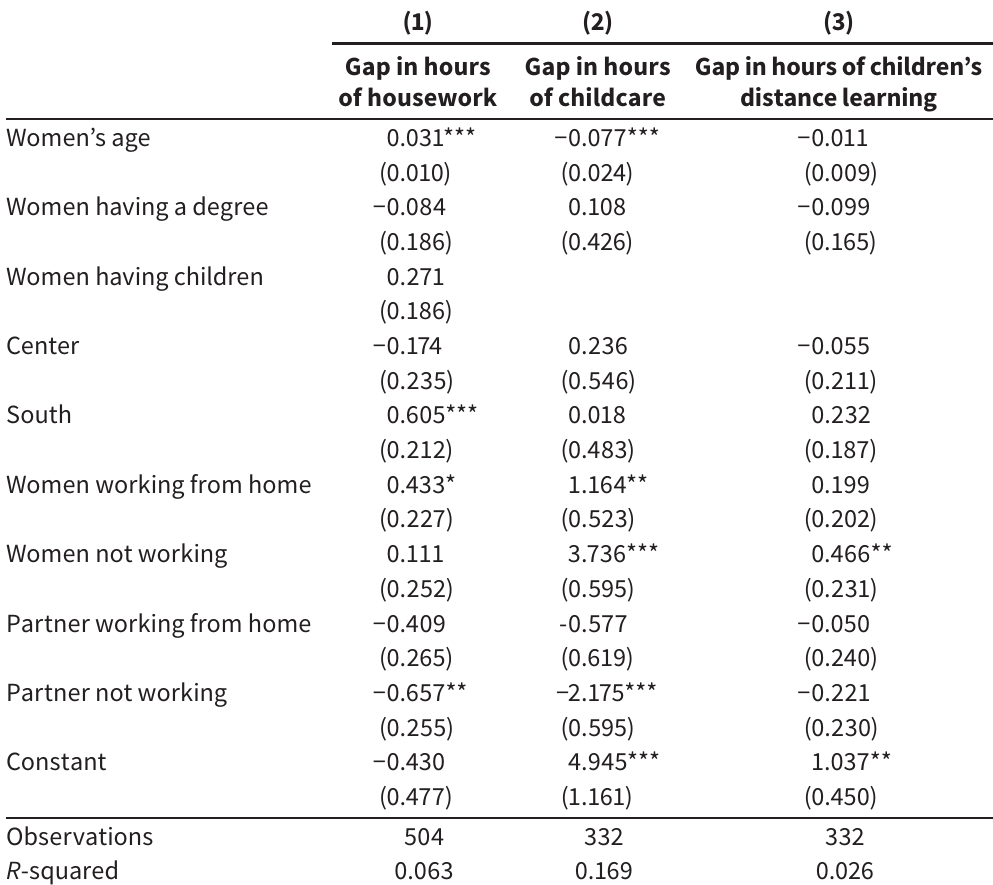
Table 6 Multivariate regression model of gender gaps in the daily hours of housework, childcare, and children’s distance learning during the second wave of COVID-19 (1) (2) (3) Gap in hours Gap in hours Gap in hours of children’s of housework of childcare distance